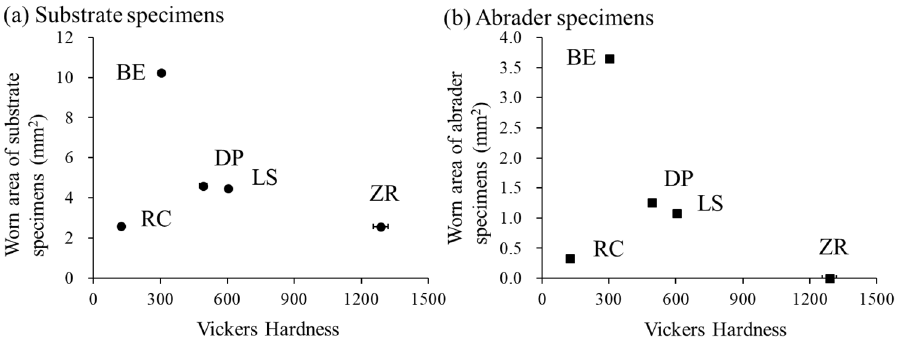
Figure 6. The relationships between the specimen-worn area and Vickers hardness of the abrader specimen (( a ): worn by substrate specimens, ( b ): worn by abrader specimens). Abbreviations of each experimental group are shown in Table 1.